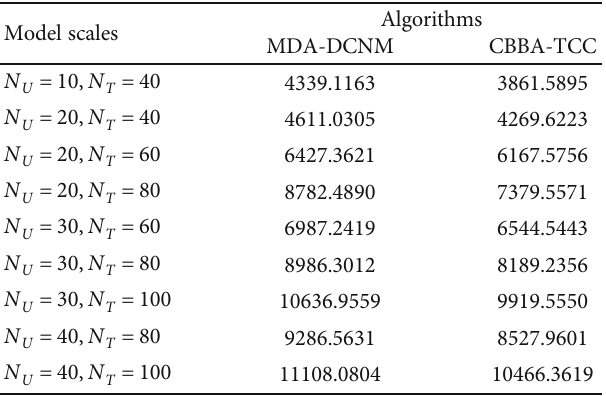
Table 9: Scores of two algorithms under di ff erent model scales. Model